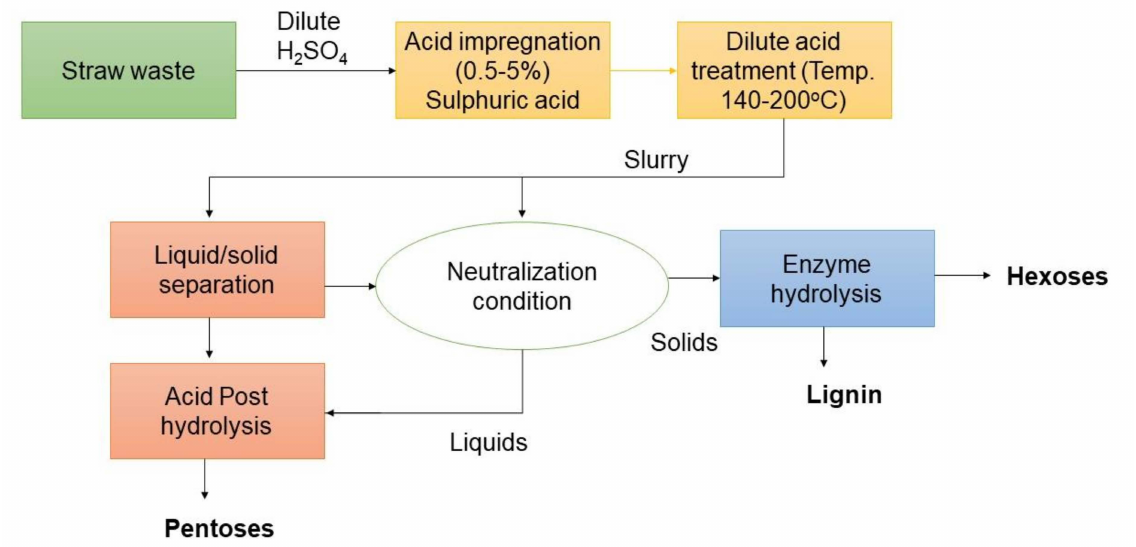
Figure 2. Schematic representation of sulphuric acid